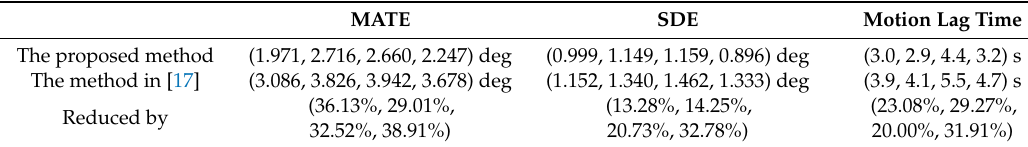
Figure 4. Joint trajectory tracking curve of each joint of underwater manipulator. ( a ) Neck joint; ( b ) shoulder joint; ( c ) elbow joint; and ( d ) wrist joint. Table 4. Pool-experiment results of sinusoidal trajectory tracking.